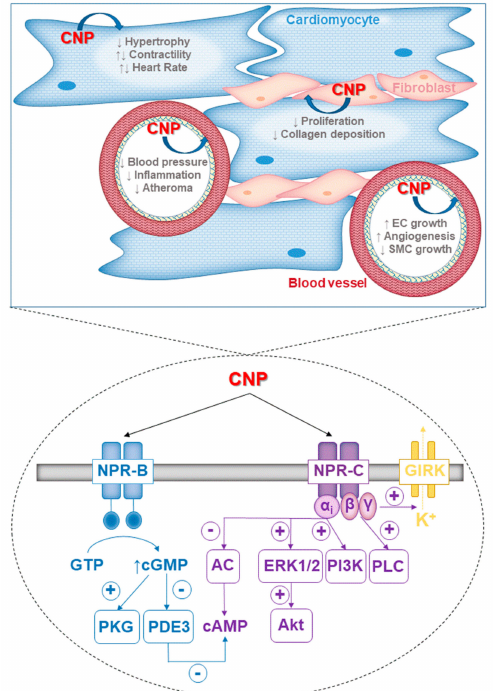
Figure 1. (Patho)physiological functions (upper panel) and signalling pathways (lower panel) activated by CNP in endothelial cells, cardiomyocytes, and fibroblasts. In the heart, CNP reduces cardiac hypertrophy, inhibits fibrosis, and modulates myocyte inotropy and chronotropy. In the vasculature, CNPlowersbloodpressure, inhibitsinflammation, reducesatheroscleroticplaquedeposition, modulates endothelial cell (EC) and smooth muscle cell (SMC) growth, and stimulates angiogenesis. The cellular e ff ects of CNP are mediated via two cognate receptors, NPR-B and NPR-C. NPR-B is a particulate guanylyl cyclase receptor and stimulation results in the production of cGMP and the activation of protein kinase G (PKG) I. NPR-C is G i protein-linked receptor that modulates various intracellular enzymes including adenylyl cyclase (AC), phospholipase C (PLC), extracellular signal-related kinase (ERK) 1 / 2, phosphoinositide-3-kinase (PI3K), and protein kinase B (Akt). NPR-C activation also triggers the opening of G-protein gated inwardly rectifying potassium (GIRK) channels. Cross-talk occurs between the two receptor signalling pathways via cGMP-mediated inhibition of phosphodiesterase (PDE) 3, the enzyme responsible for the hydrolysis of cAMP in